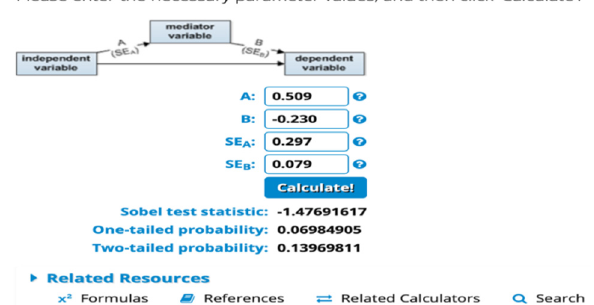
Figure 5. Sobel Test Result ABRs → Earnings Management → Sukuk Rating. Source: Sobel Test Output, available online: https://www.danielsoper.com/statcalc/calculator.aspx?id=31, accessed on 5 January 2022.